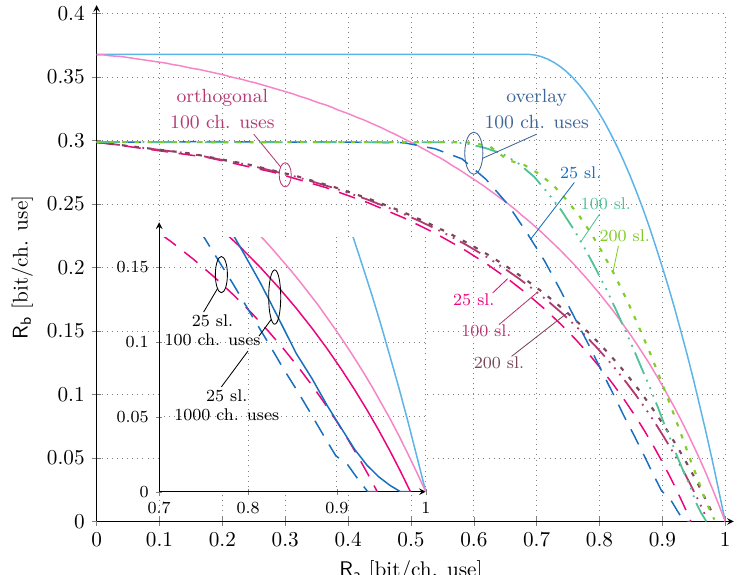
Figure 4. Finite length results for orthogonal and overlay allocations. We fix ρ a / σ 2 = ρ b / σ 2 = 0 dB. The number of time slots are in the set M ∈ { 25,100,200 } , the number of channel uses per time slot are n s ∈ { 100,1000 } and the target average codeword error probability for service S a is 10 − 3 . The asymptotic ergodic rate region for the both orthogonal and overlay allocations are also provided for